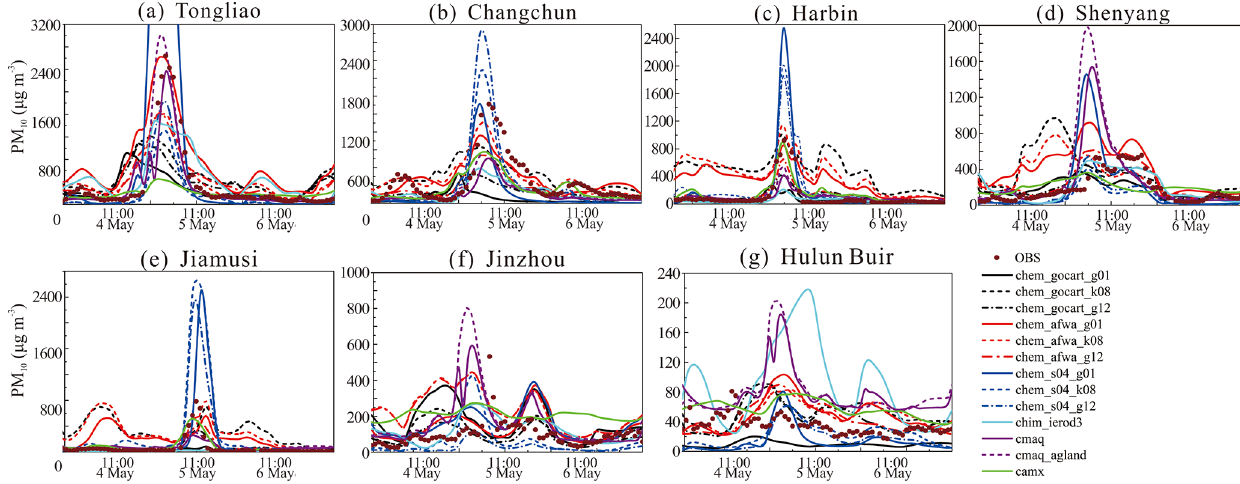
Figure 12. Time series (UTC) of hourly PM 10 for the simulations and measurements at four central sites (Tongliao, a ; Changchun, b ; Harbin, c ; and Shenyang, d ); one NE site, Jiamusi (e) ; one SW site, Jinzhou (f) ; and one NW site, Hulun Buir (g) , between 4 and 6 May 2015. Simulation labels follow Fig.